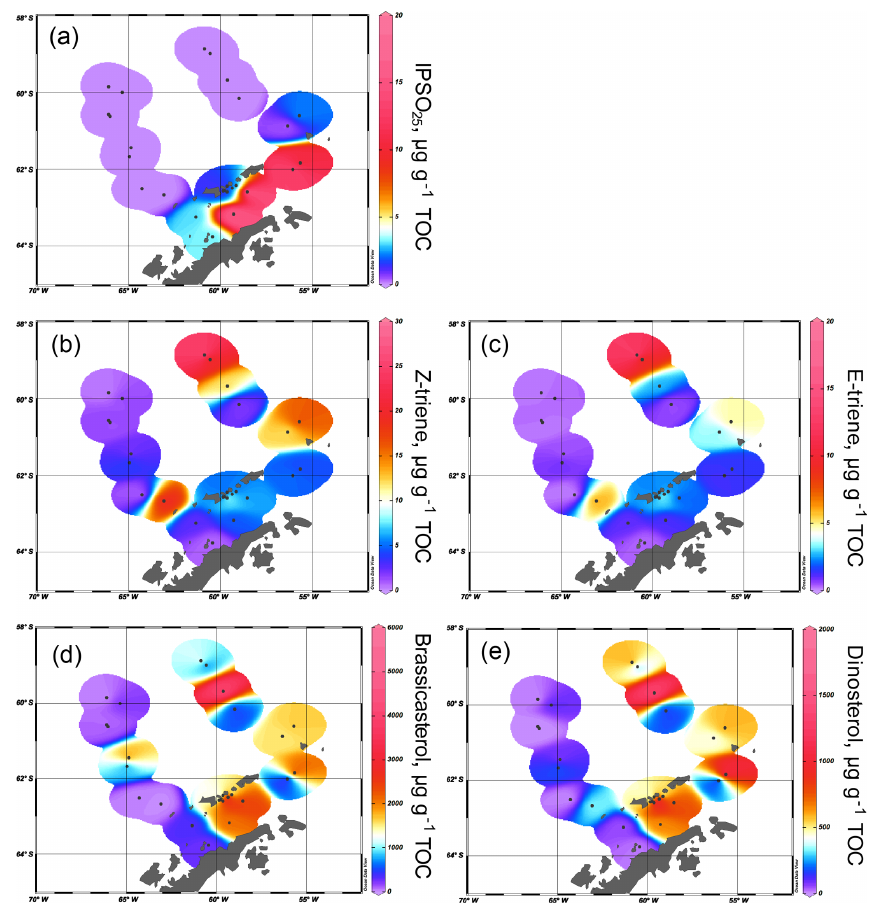
Figure 3. Distribution of (a) IPSO 25 , (b) HBI Z-triene, (c) HBI E-triene, (d) brassicasterol and (e) dinosterol concentrations normalized to TOC. All distribution plots were made with Ocean Data View